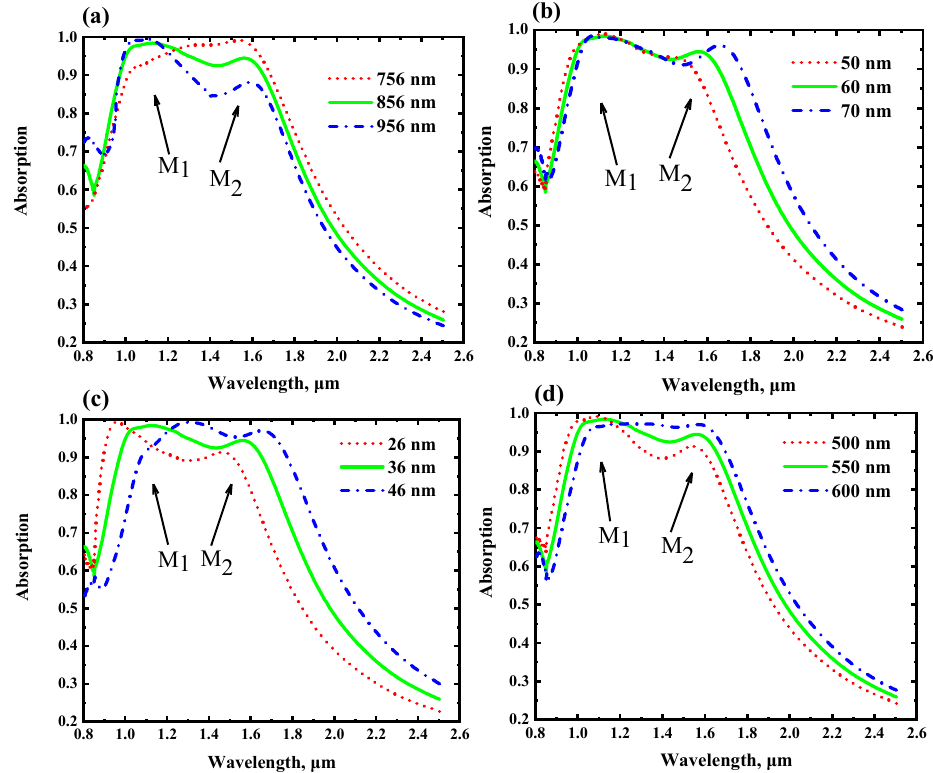
Figure 6. Effects of changing geometric parameters. ( a ) Changing the period. ( b ) Changing the thickness of the continuous silicon layer. ( c ) Changing the thickness of the silicon square. ( d ) Changing the side length of the silicon square.